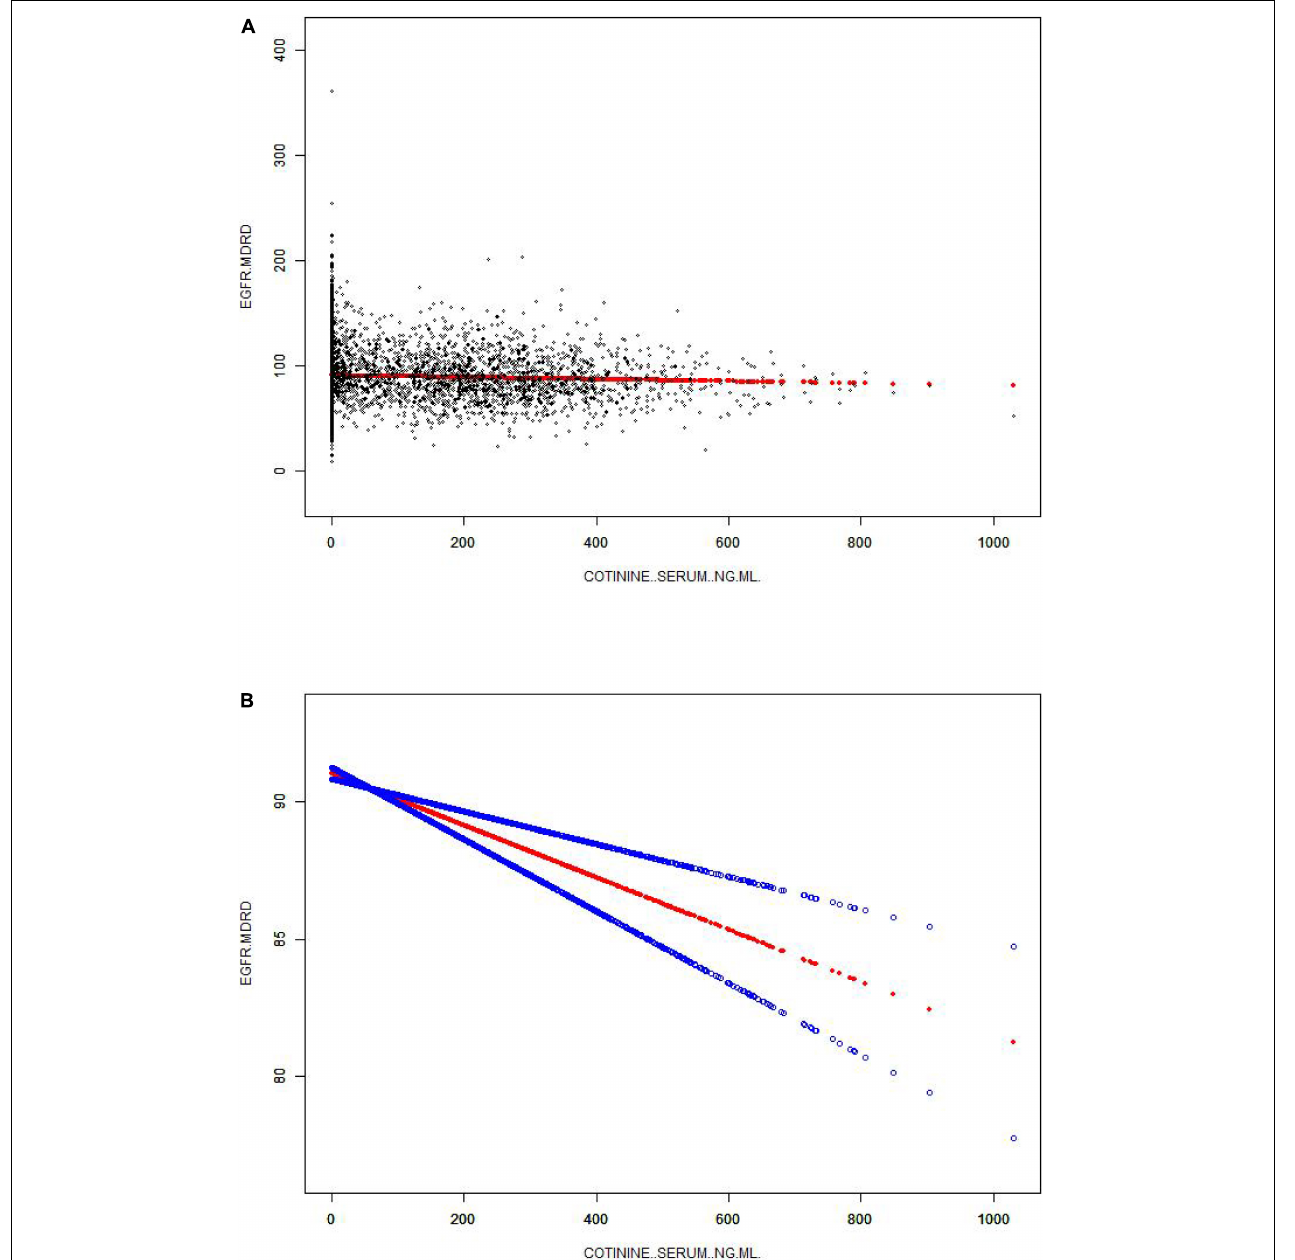
FIGURE 2 | The association between serum cotinine and the eGFR. (A) Each black point represents a sample. (B) The solid red line represents the smooth curve fit between variables. Blue bands represent the 95% CI from the fit. Age, sex, race/ethnicity, educational background, the ratio of family poverty to income, marital status, BMI, glycosylated hemoglobin, blood glucose, BUN, triglycerides, and uric acid albumin were adjusted.